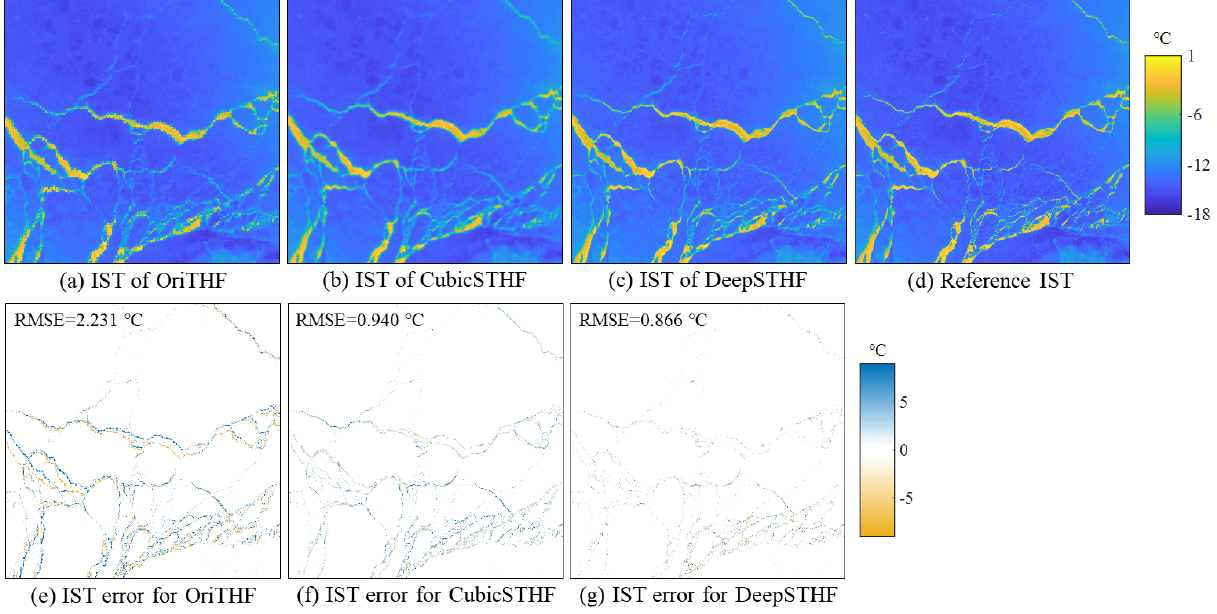
Figure 6. Simulated MODIS IST image and SR results of different methods. (a) The IST obtained by the OriTHF; (b) the IST obtained by the CubicSTHF; (c) the IST obtained by the DeepSTHF; (d) the reference IST; (e) the IST error of the OriTHF; (f) the IST error of the CubicTHF method; (g) the IST error of the DeepSTHF method.